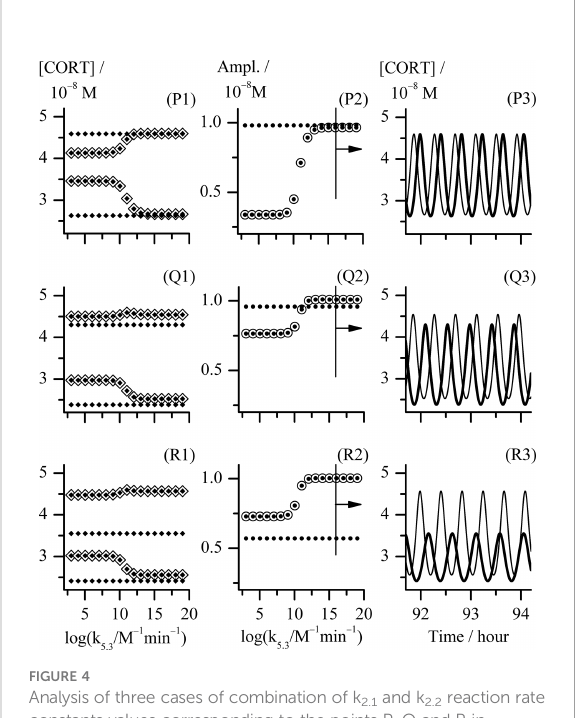
FIGURE 4 Analysis of three cases of combination of k 2.1 and k 2.2 reaction rate constants values corresponding to the points P, Q and R in Figure 2. Point P, k 2.1 = k 2.2 = 1.830 × 10 − 8 mol dm − 3 min − 1 ; point Q, (k 2.1 and k 2.2 ) = (1.738 and 2.745) × 10 − 8 mol dm − 3 min − 1 , respectively; point R, (k 2.1 and k 2.2 ) = (1.647 and 4.575) × 10 − 8 mol dm − 3 min − 1 , respectively; (P1) - (R1) bifurcation diagrams and (P2) - (R2) diagrams of change of [CORT] oscillation amplitudes each obtained with k 5.3 as control parameter using Method 2; (P3) - (R3) temporal evolutions of [CORT] for k 5.3 = 1.098 × 10 16 mol − 1 dm 3 HPA axis model (54) in diagrams (P1) - (R1), (P2) - (R2) and (P3) - (R3) are depicted by ♦ , ● and thicker curves, respectively. In (P1)